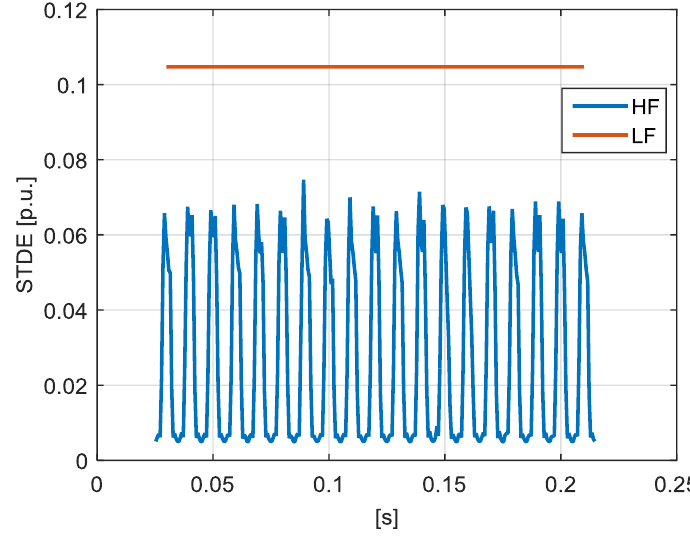
Figure 4. Case study 1: STDE at low-frequency (0 ÷ 2 kHz, red line) and at high-frequency (2 ÷ 150 kHz, blue line) obtained by the instantaneous approach.